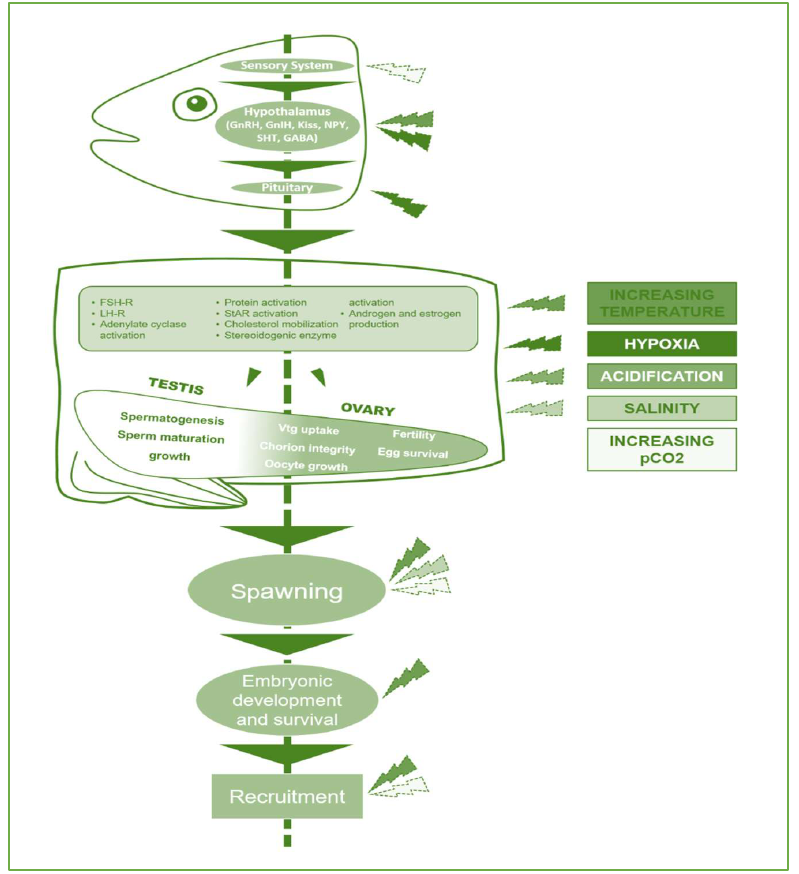
Figure 2. Signaling regulation: hypothalamus-pituitary-gonad-spawning-embryonic development altered by abiotic factors. Abbreviations: GnRH, gonadotropin releasing hormone; GnIH, Gonadotropin-inhibitory hormone; Kiss, kisspeptin; NPY, neuropeptide Y; SHT, somatotropin, GABA, gamma-aminobutyric